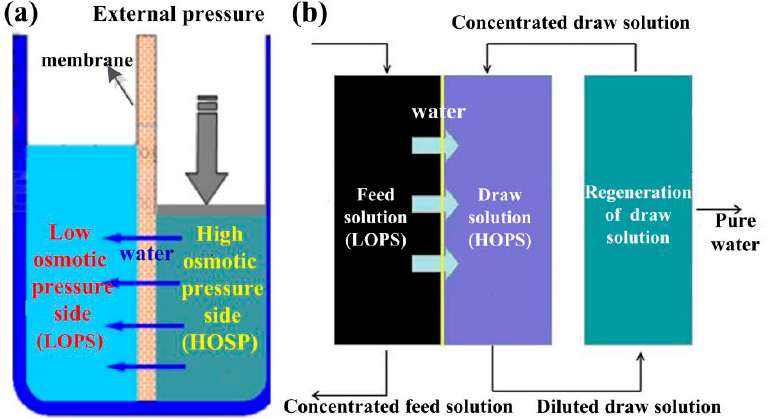
Figure 1. Schematic representation of the reverse osmosis process ( a ) and forward osmosis process ( b ). Rapid progress in the fabrication of the FO membranes has been seen in the last decade.